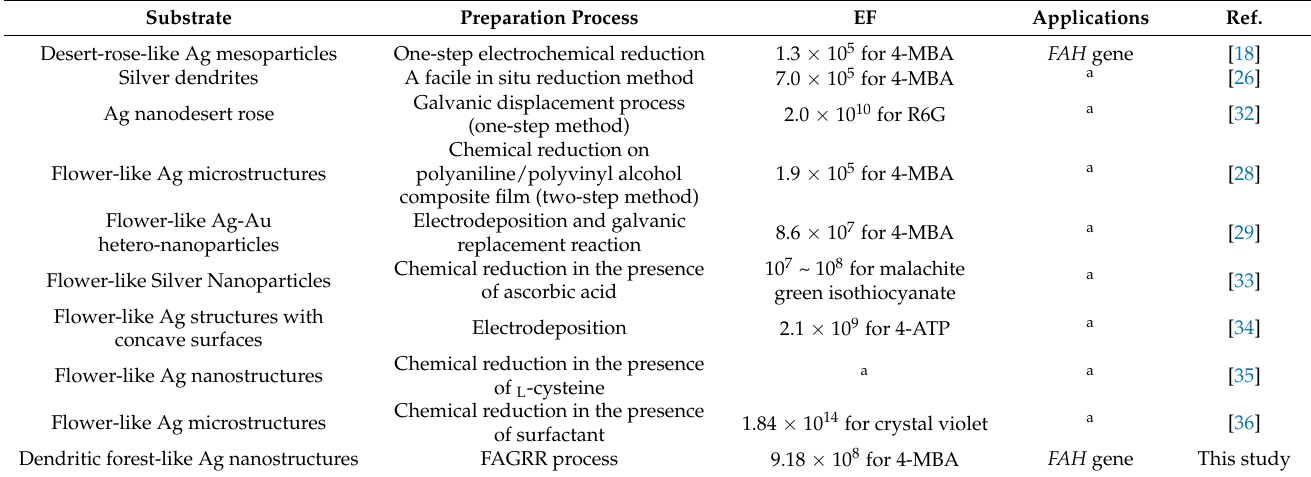
Table 2. Fabrication method, EFs, and applications of various flower-like Ag